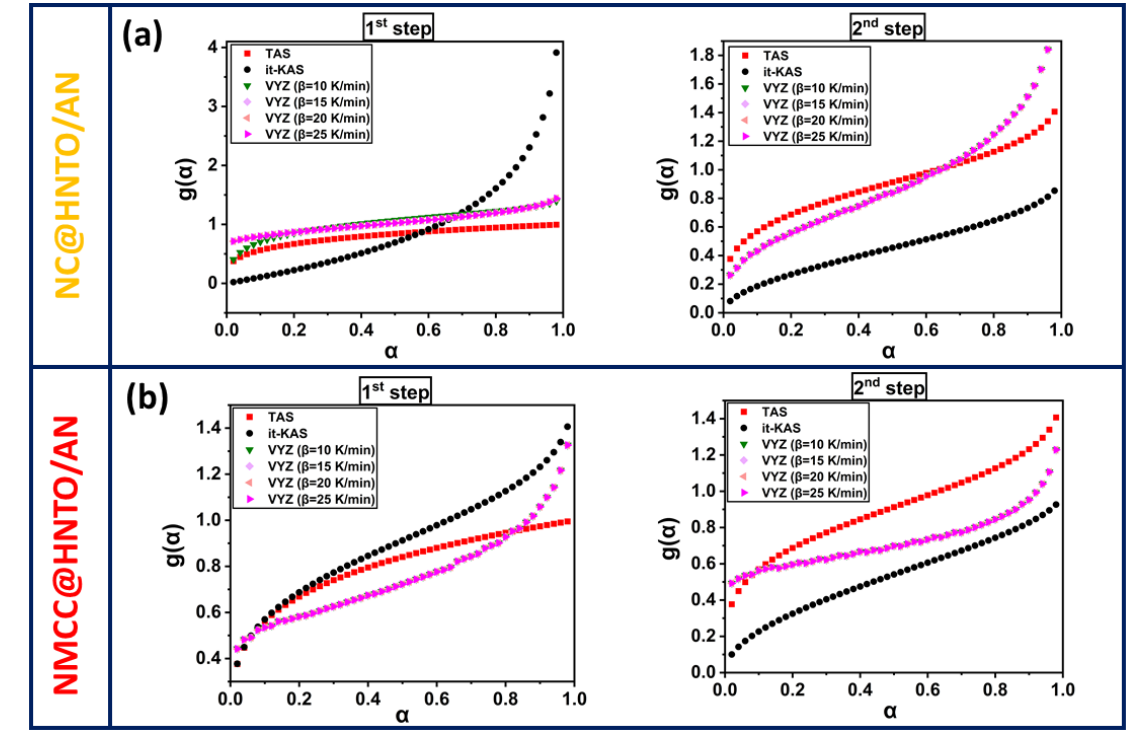
Figure 7. Evolution of the integral reaction model as a function of conversion for the different decomposition stages of ( a ) NC@HNTO/AN; ( b ) NMCC@HNTO/AN.